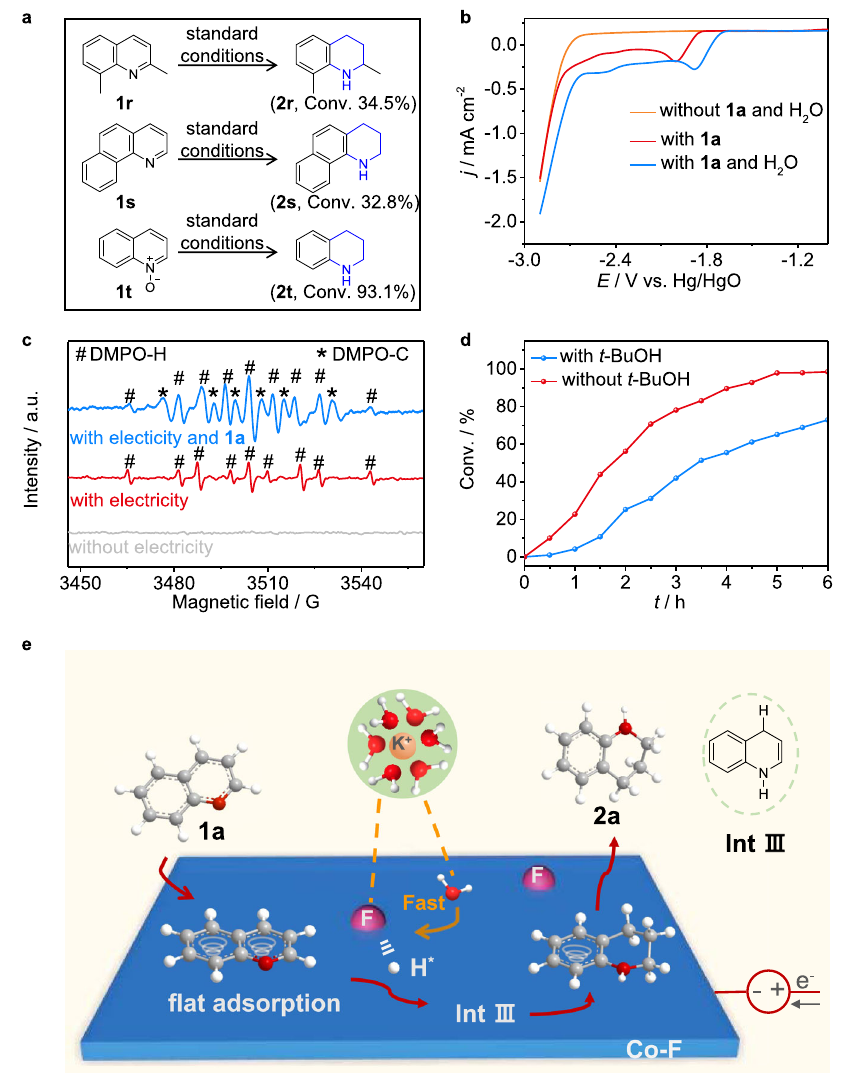
Fig. 4 | Mechanistic studies of electrocatalytic hydrogenation of quinolines over a Co-F cathode. a Control experiments: substrates (0.2mmol, 28.57mmolL − 1 ), Co-F electrode (working area: 1.0cm 2 ), a mixed solution of 1.0M KOH/dioxane (6:1v/v, 7mL), − 1.1V, RT, 12h. b LSV curves in anhydrous